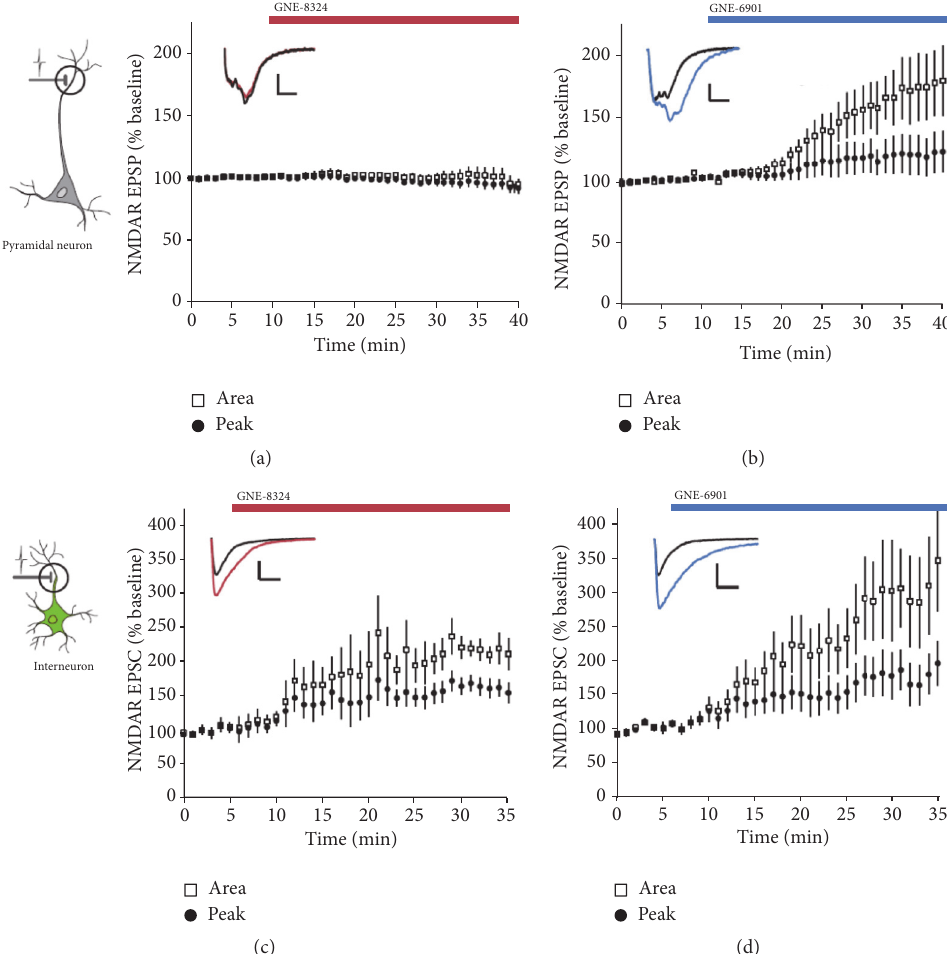
Figure 1: Cell type-specific effects of NMDAR-PAMs. (a) GNE-8324 has no effect on NMDAR EPSPs recorded from CA1 pyramidal neurons in acute brain slices. (b) In contrast, GNE-6901 showed robust potentiation on NMDAR EPSPs under the same condition. (c, d) Robust potentiation of both GNE-8324 and GNE-6901 on NMDAR EPSCs recorded in the inhibitory neurons in the hippocampus. Modified from